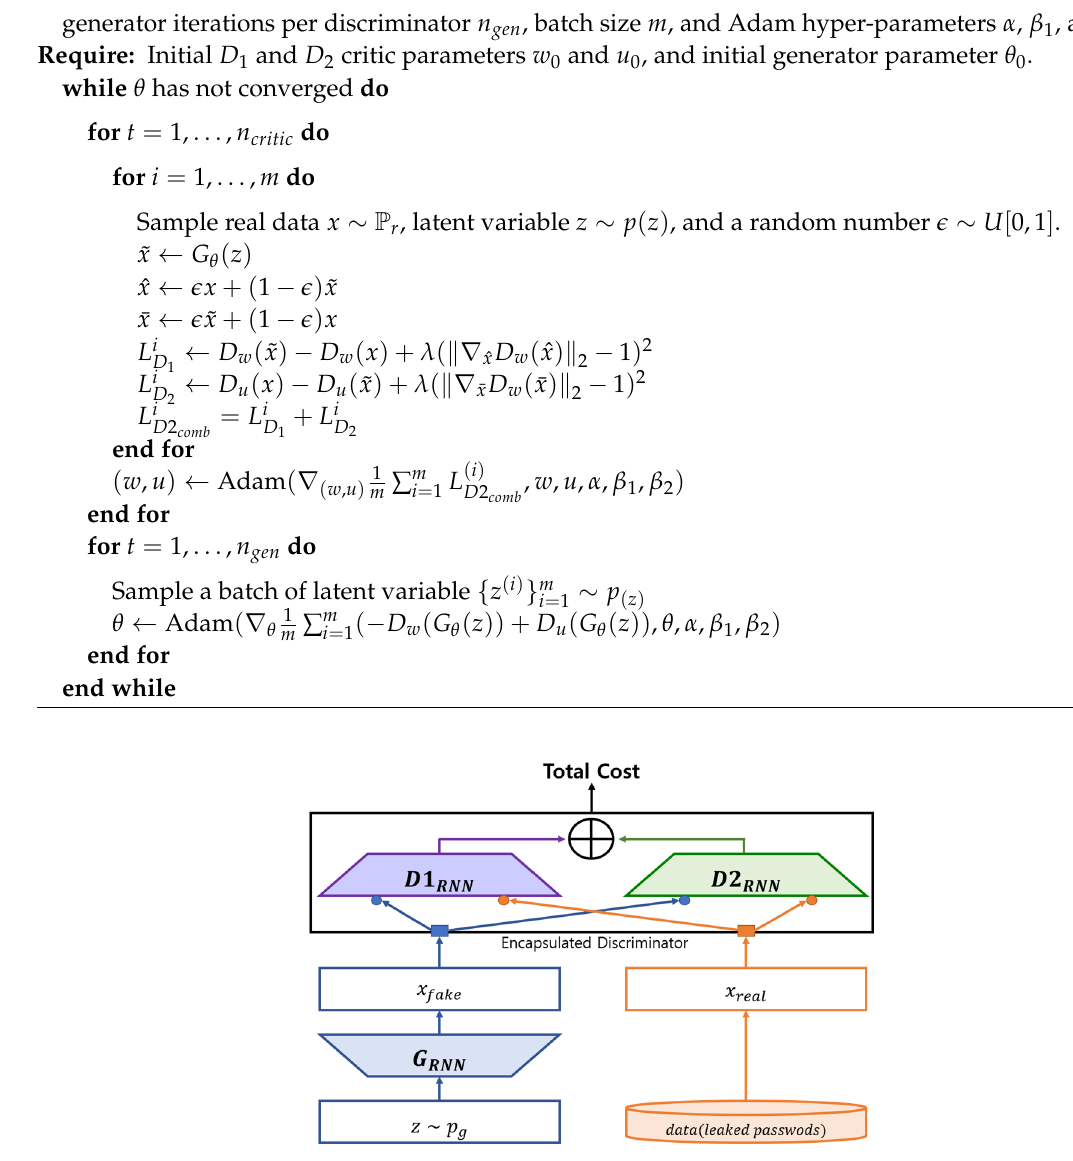
Algorithm 1 rPassD2CGAN calculates each discriminator’s gradient penalty. We use the default values λ = 10, n critic = 10, n gen = 40, α = 0.0001, β 1 = 0.5 and β 2 = 0.9.